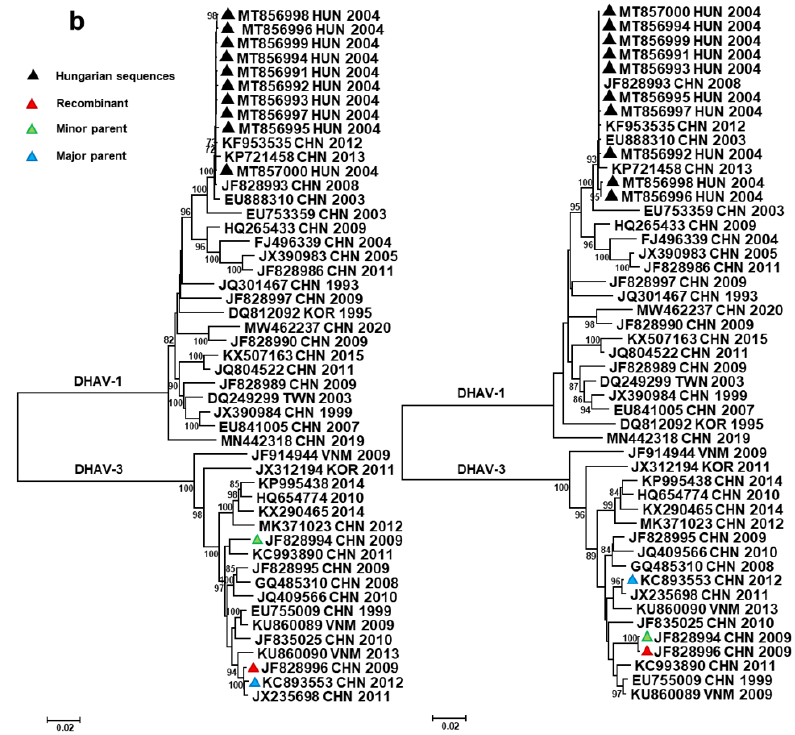
Figure 2. Unrooted neighbor-joining phylogenetic trees representing intergenotypic ( a ) and in- tragenotypic ( b ) recombination events. The trees were generated with a p -distance model (1000 boot- strap replicates) using sequence alignments extracted from polyprotein sequences according to the predicted recombination points determined with RDP4 software. The trees show groupings of recombinant strains with the putative major (tree on the left) and minor (tree on the right) parents (or related strains with GenBank records in all cases when true parents are unknown). Table 2. Inter- and intragenotype recombination events affecting DHAV genomes, as revealed by recombination analysis. Event *